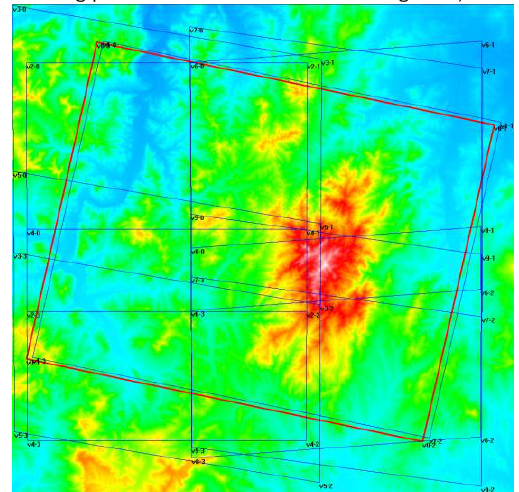
Figure 1. Terrain and zone of Worldview-2 and simulated GF-7